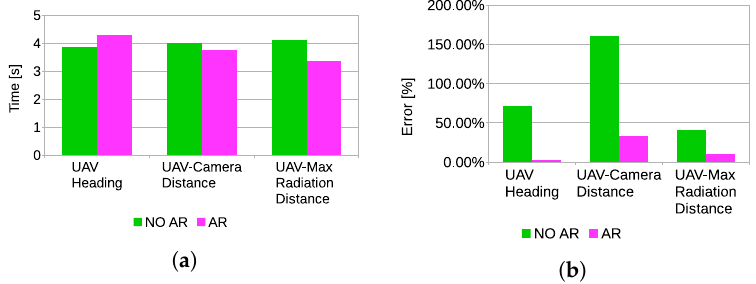
Figure 20. Situation present assessment method (SPAM) questionnaire results. ( a ) response time; ( b ) parameter estimation